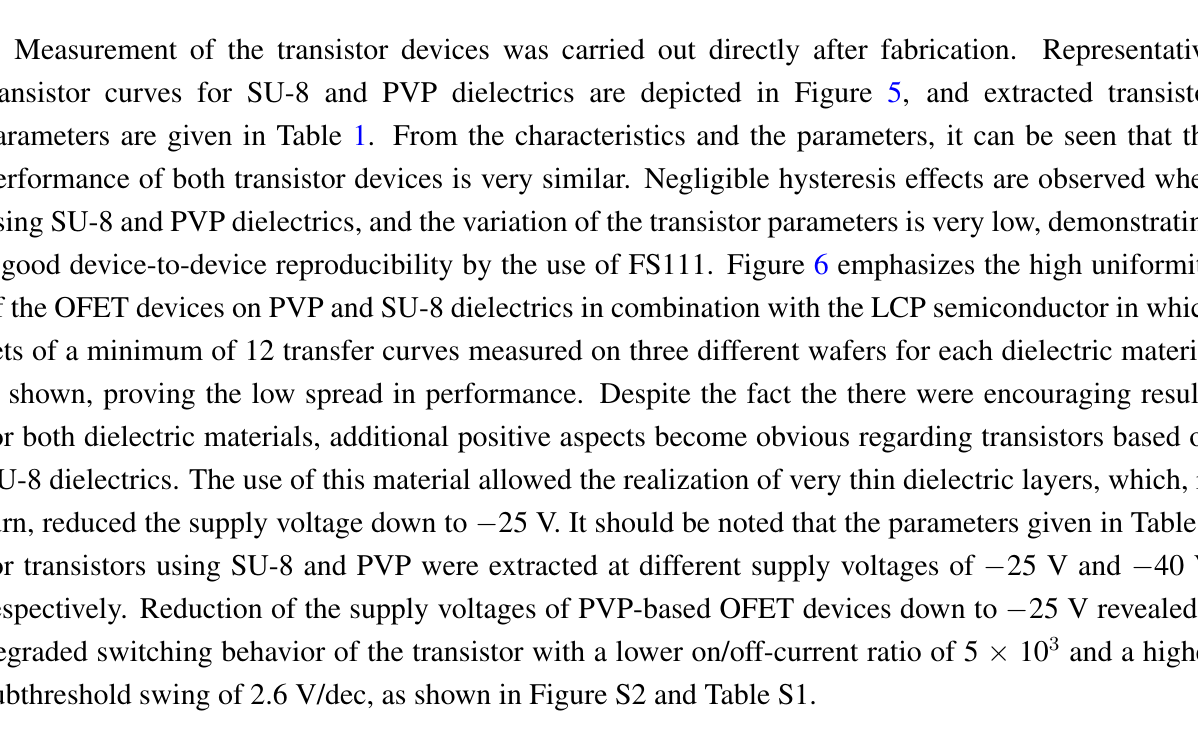
Table 1. Extracted parameters for FS111 using SU-8 dielectrics on FOC and PVP dielectrics on